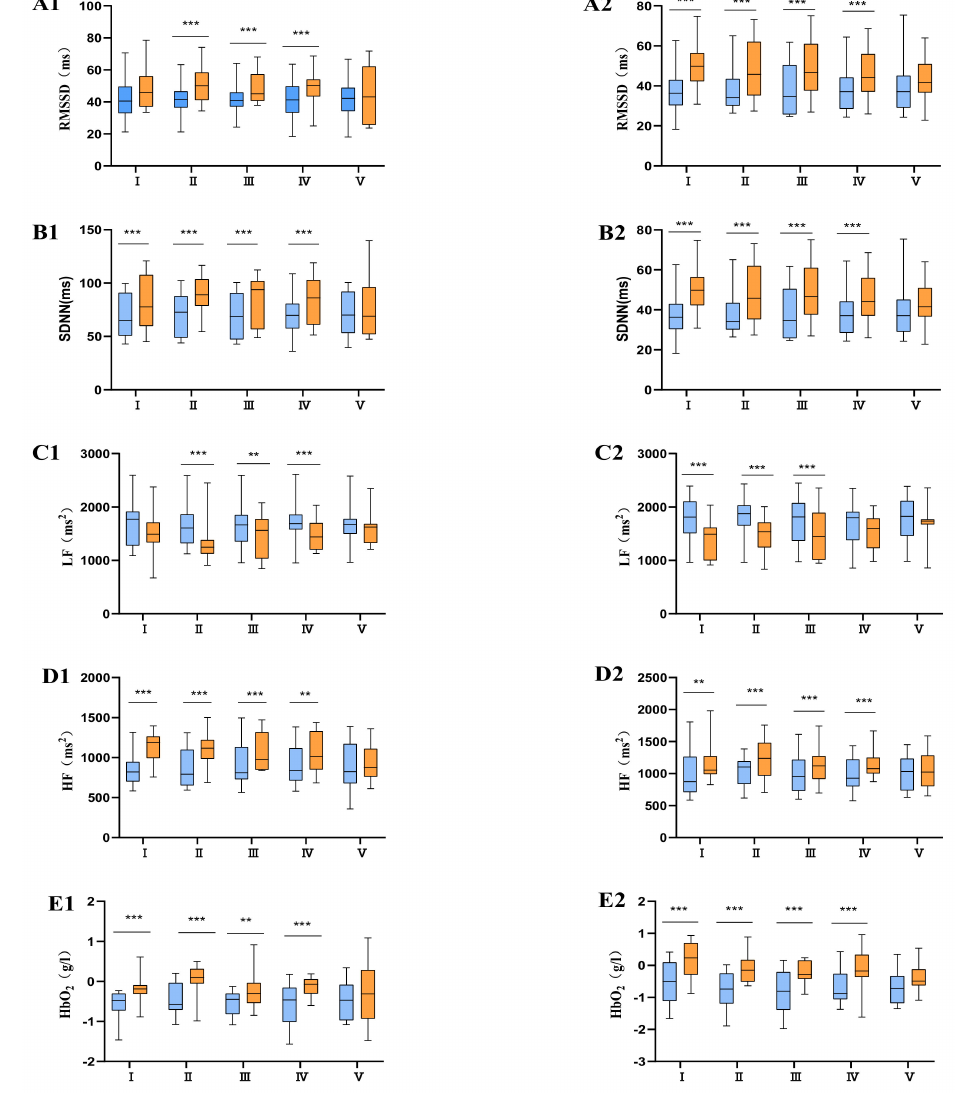
Figure 4. Effects of tPCS intervention programs on the indicators of HVR and HbO 2 after physical fatigue. Note: ( A ) Effects of tPCS intervention on RMSSD. ( B ) Effects of tPCS intervention on SDNN. ( C ) Effects of tPCS intervention on LF. ( D ) Effects of tPCS intervention on HF. ( E ) Effects of tPCS intervention on HbO 2 . ** represents p < 0.05; *** represents p < 0.01; means before